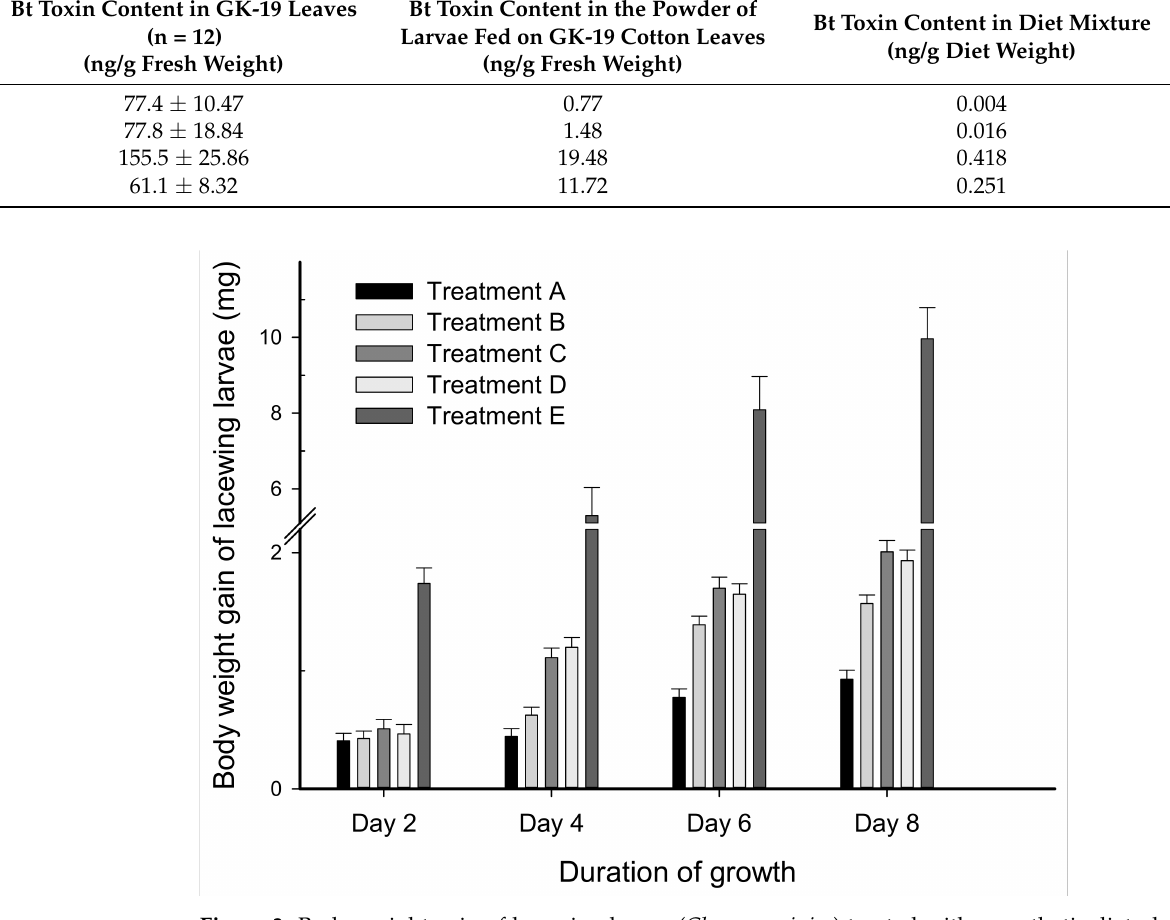
Figure 3. Body-weight gain of lacewing larvae ( Chrysopa sinica ) treated with a synthetic diet plus larval powder of beet armyworm (BAW) fed on transgenic cotton (GK-19) (Treatment A), synthetic diet plus larval powder of BAW fed on non-transgenic cotton (Simian-3) (Treatment B), synthetic diet plus synthetic Bt pro-toxin (Treatment C), blank synthetic diet (Treatment D), and aphids (Treatment E),